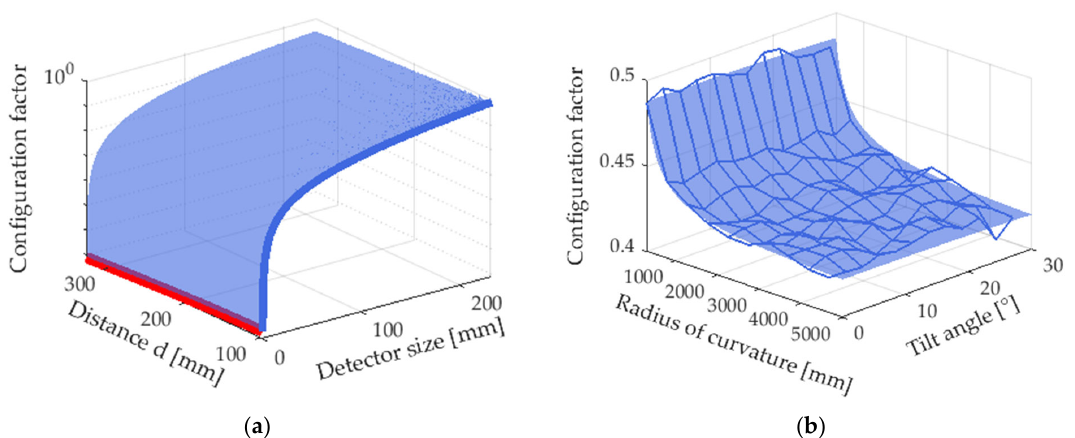
Figure 5. The calculated results of the configuration factors under different optical layouts. ( a ) The configuration factors as a function of distance d, detector size r 2 . The blue and orange solid lines are the analytical results; ( b ) The plot of configuration factors as a function of radius of curvature R and tilt angle. The curve is the analytical results and the grid is for the calculated result.